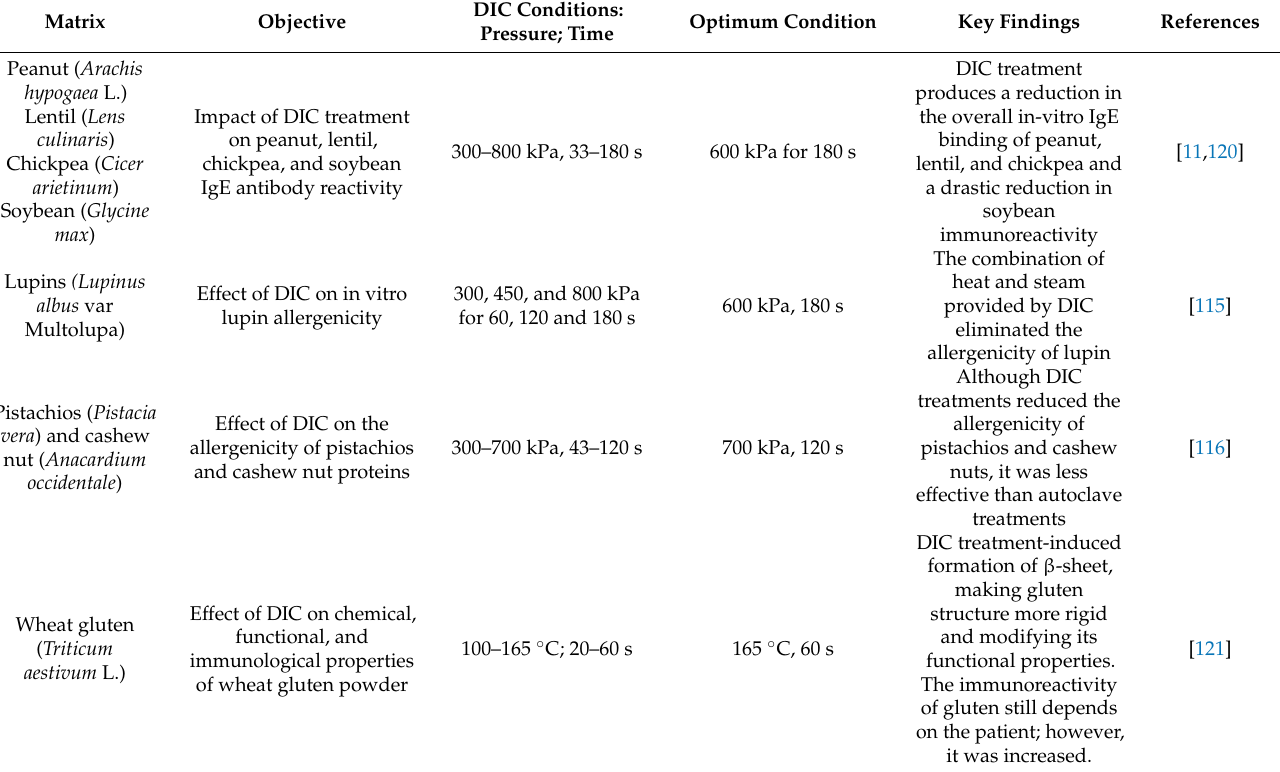
Table 9. DIC treatment of legumes to reduce